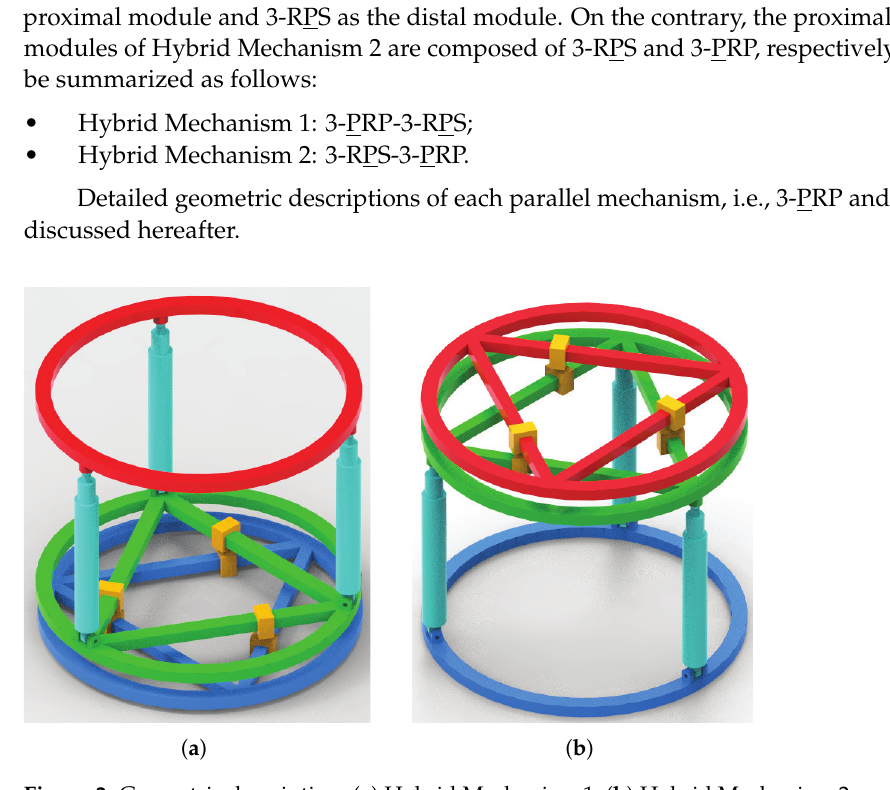
Figure 2. Geometric description: ( a ) Hybrid Mechanism 1, ( b ) Hybrid Mechanism